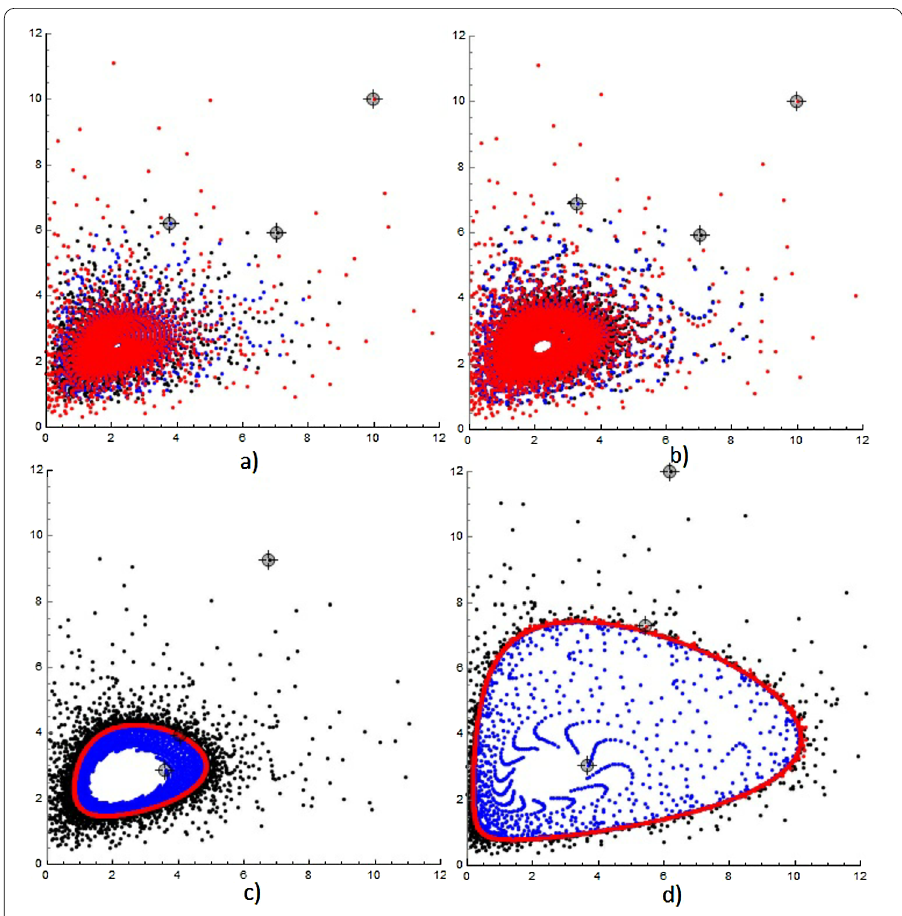
Figure 3 Trajectories (orange, black, and red) for b = 0.42, c = 0.71, m = 0.5, where a 0 ≈ 4.92155, d